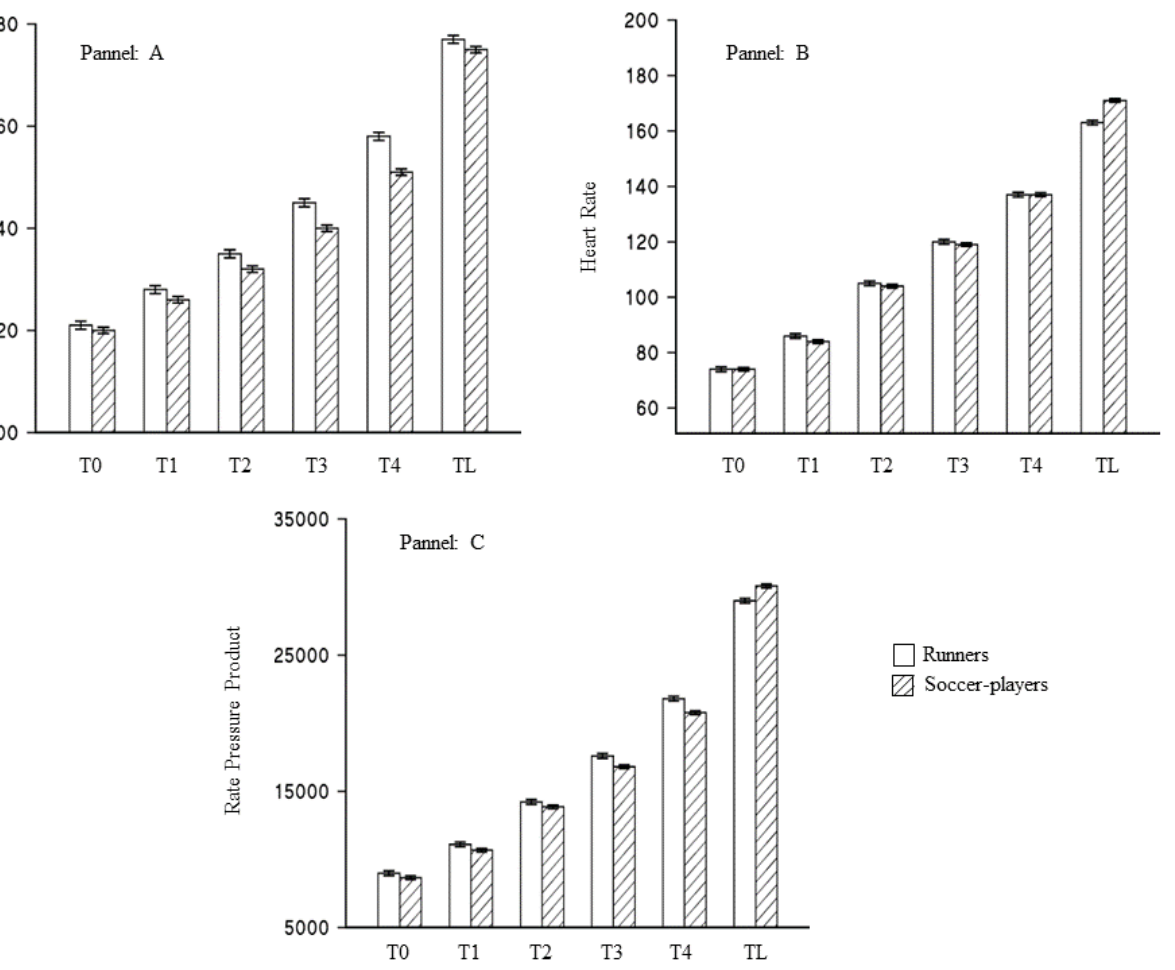
Figure 2. Variation of cardiovascular markers during the treadmill stress test according to the type of sports. Blank boxes represent runners, whereas dashed were soccer players. T0 was the warm-up; TL was the last step reached during the test. In the panel: ( A ) systolic blood pressure (mm/Hg); ( B ) heart rate (bp/min); ( C ) rate pressure product (bp/min*mm/Hg).